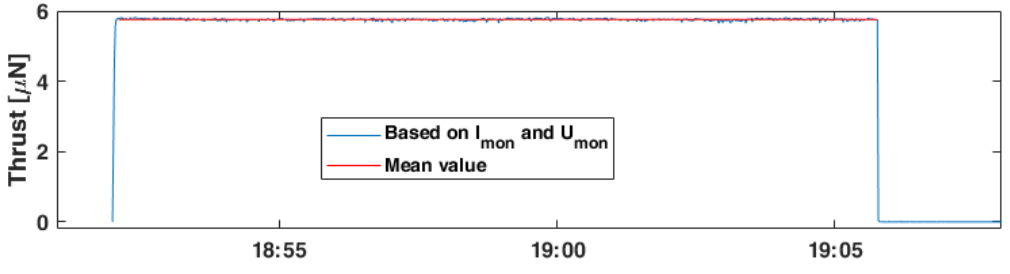
Figure 16. Thrust magnitude of thruster B during experiment on 31 May 2020 according to Equation (1) in blue. The mean value is depicted in red.